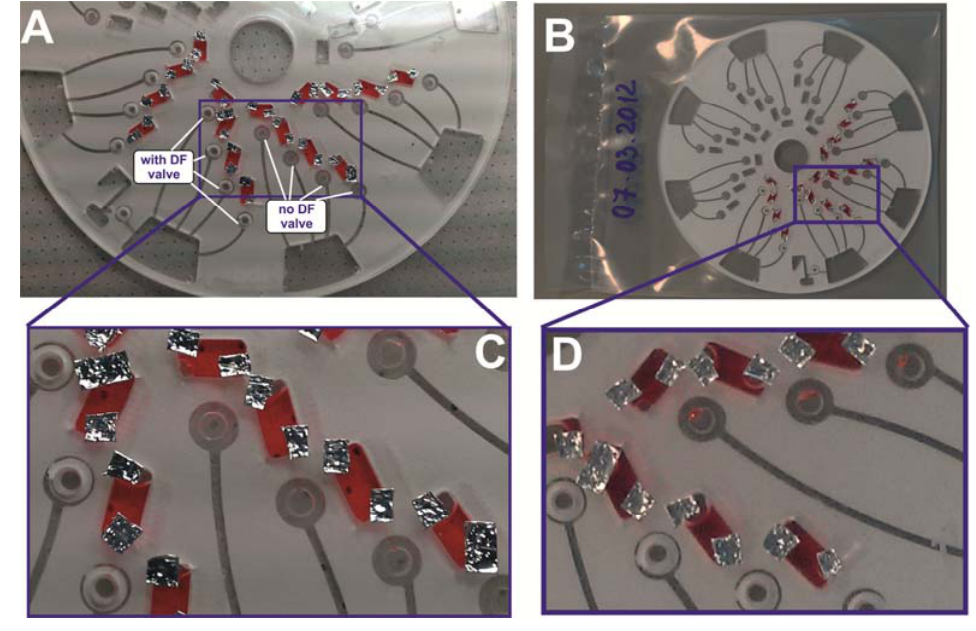
Figure 7. ( A ) Image of the microfluidic disc pre-loaded with red food dye, stored in a heat sealed bag in the fridge at ~4 °C for 7 days. ( B ) Image of the disc after storage. ( C ) Enlarged image of the section with and without DF tabs before storage. ( D )